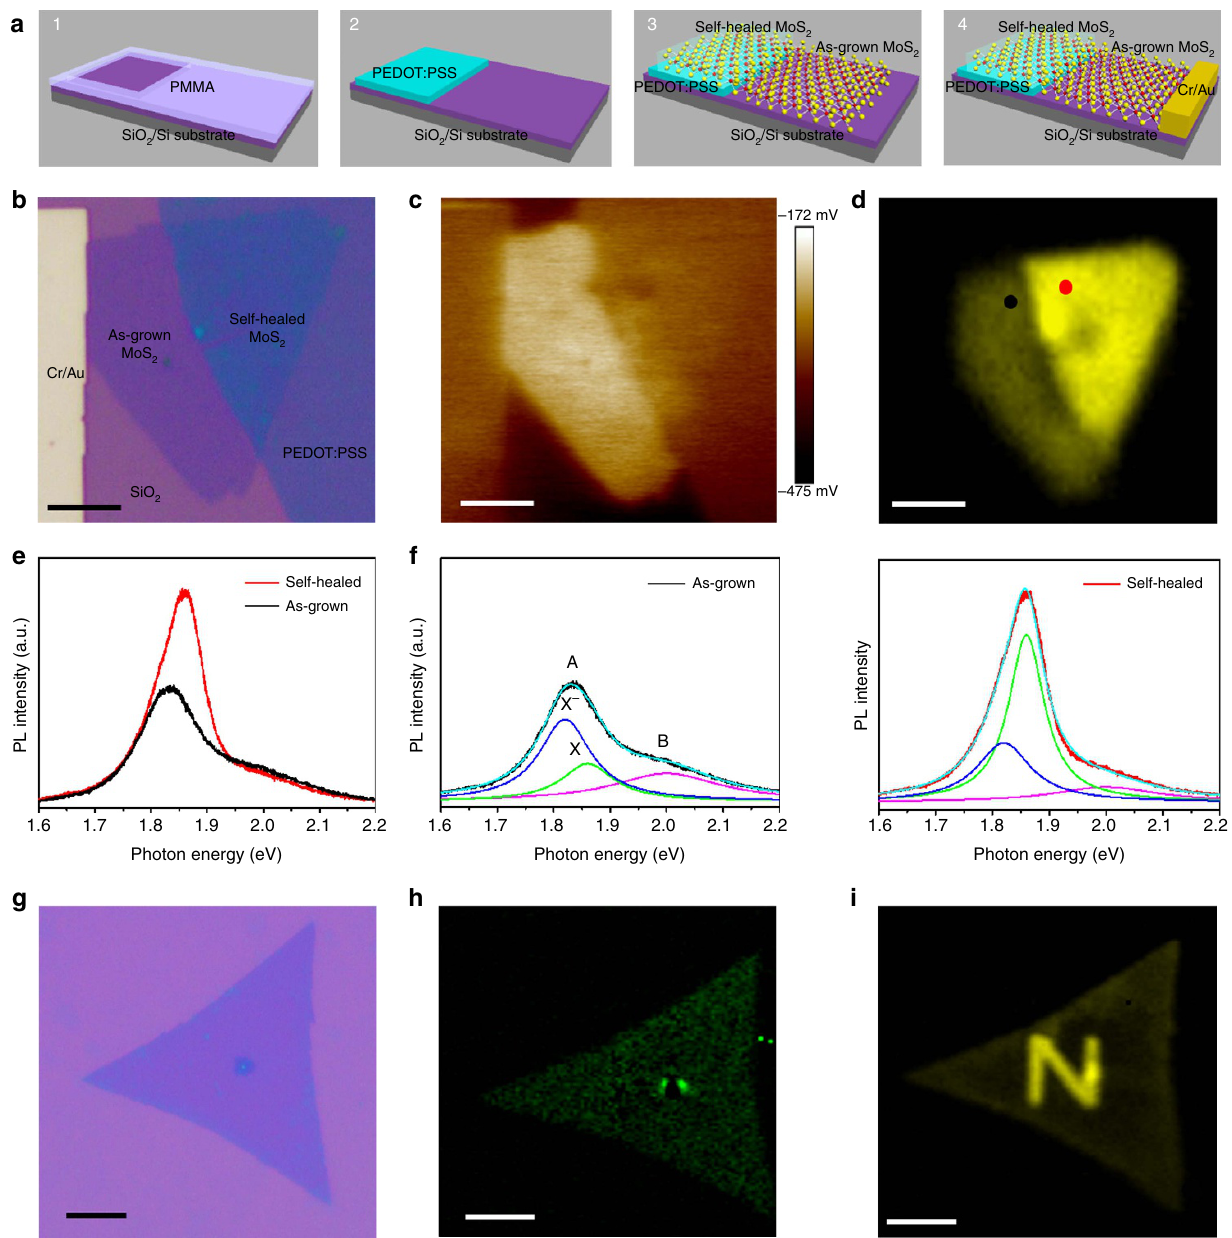
Figure 1 | Complex characterization of sulfur vacancy self-healing. ( a ) Construction process of the monolayer MoS 2 homojunction. ( b ) Optical microscopy (OM) image of the device A 1 . Scale bar, 5 m m. ( c ) Corresponding 2D surface potential image. Scale bar, 5 m m. ( d ) Photoluminescence (PL) intensity mapping. Scale bar, 5 m m. ( e ) PL spectrums acquired from different regions highlighted in d . ( f ) Comparison of the deconvoluted PL spectrum features in e . The experimental results are reproduced by the sum (cyan) of three peaks (trion X (cid:2) , blue; exciton X 0 , green; exciton B, purple) assumed by Lorentzian functions. ( g – i ) OM image, Raman mapping constructed by integrating E 1 2g mode and PL intensity mapping for a monolayer MoS 2 patterned by e-beam lithography (EBL) into the shape of the uppercase letter ‘N’ and PEDOT:PSS solution induced SVSH. Scale bar, 10 m